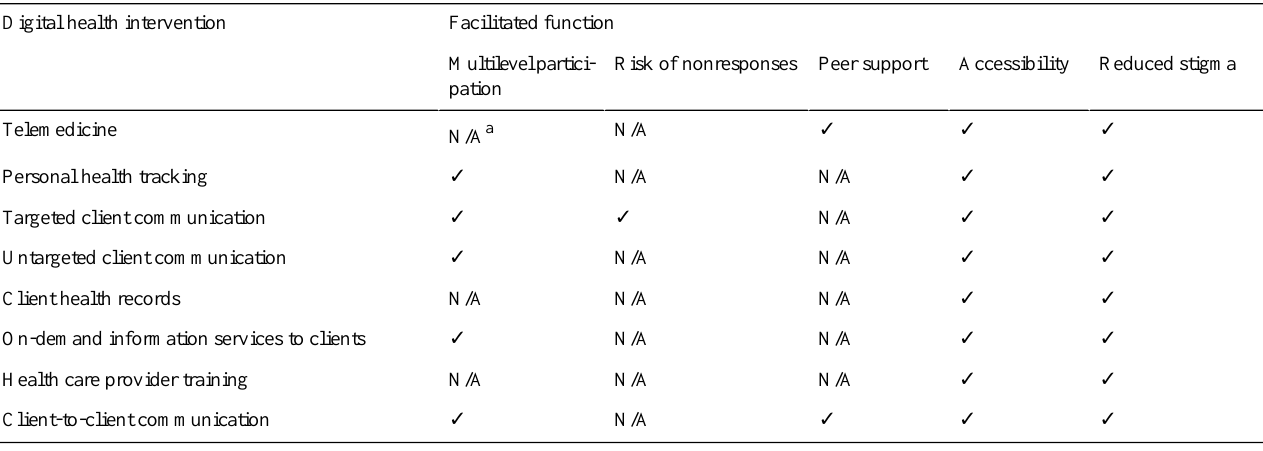
Table 7. Comparison of facilitated function and associated digital health